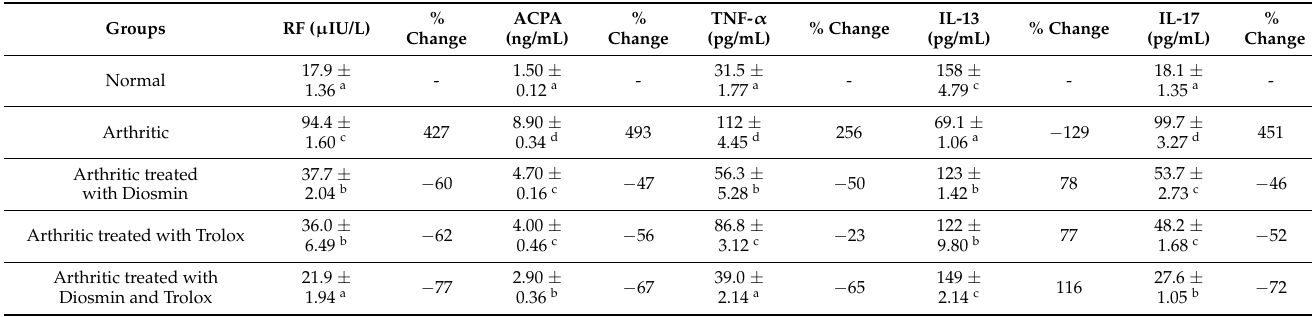
Table 2. Effect of diosmin and/ or trolox on serum RF, TNF- α , IL-13, IL-17 and ACPA level of CFA- induced arthritic